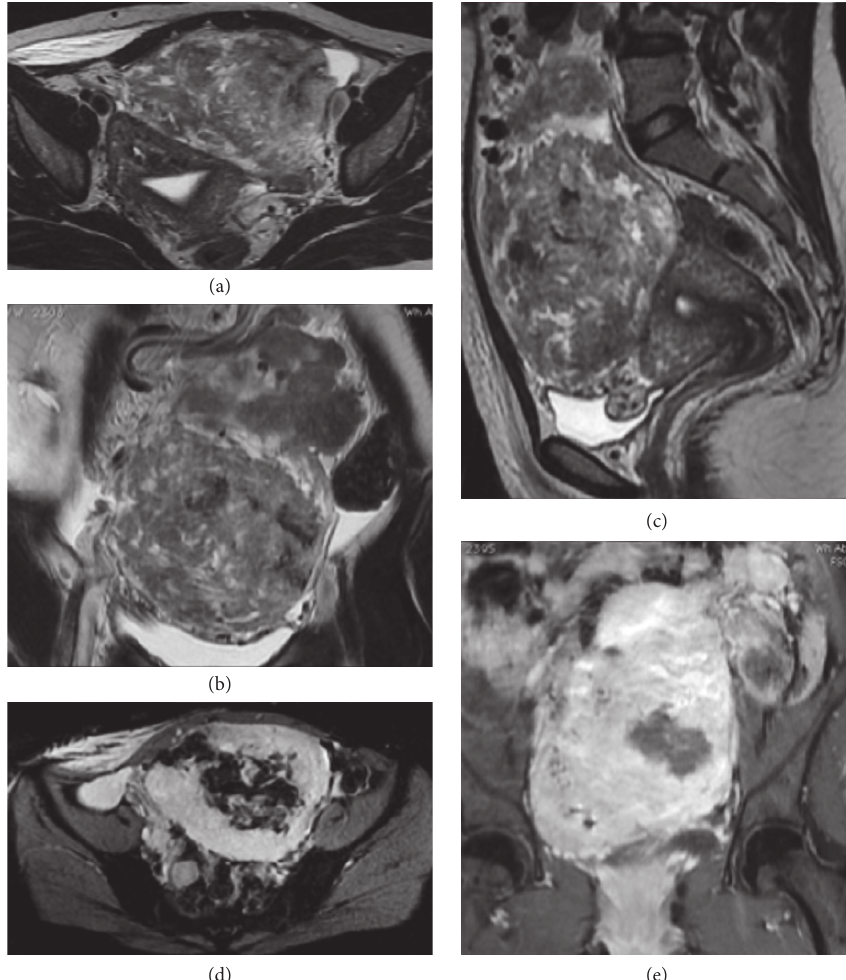
Figure 2: MRI of lower abdomen. Axial (a), coronal (b), and sagittal (c) sections of T2WI through the lower abdomen revealed a large heterogeneous pelvic-abdominal mass lesion in relation to the uterus. The mass appears to be inseparable from the adjacent mesentery and omentum. A tortuous vascular pedicle is also seen in the coronal section (b). Axial section of SWI sequence through the mass lesion showed areas of blooming suggestive of intralesional hemorrhagic foci (d). The mass lesion shows extensive enhancement after administration of gadolinium contrast